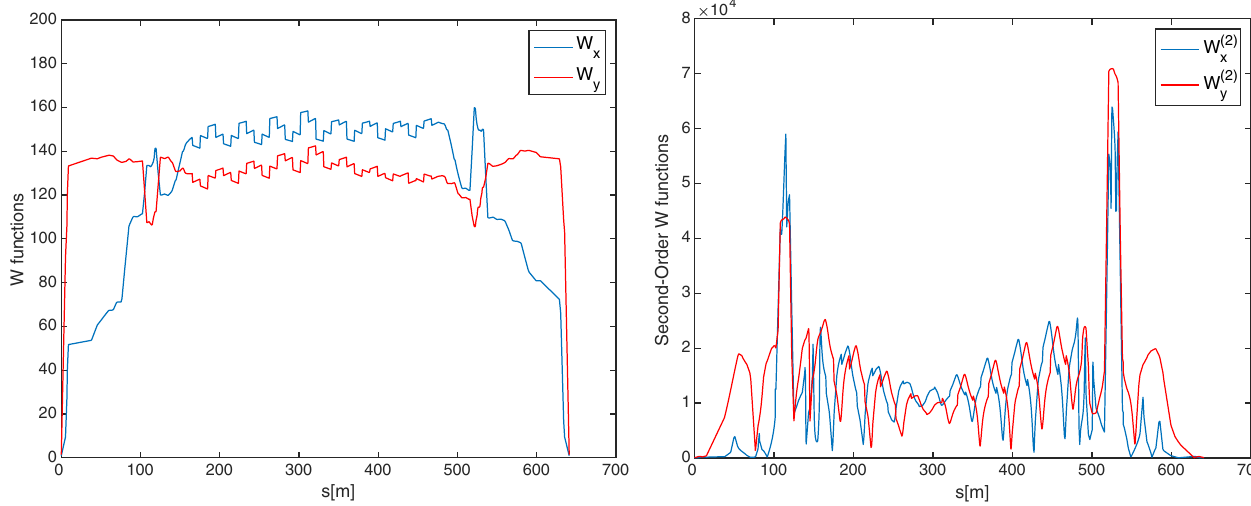
FIG. 8. Amplitudes of the first- (left) and the second-order (right) Montague functions from IR6 to IR8 using eight families of compensation sextupoles.